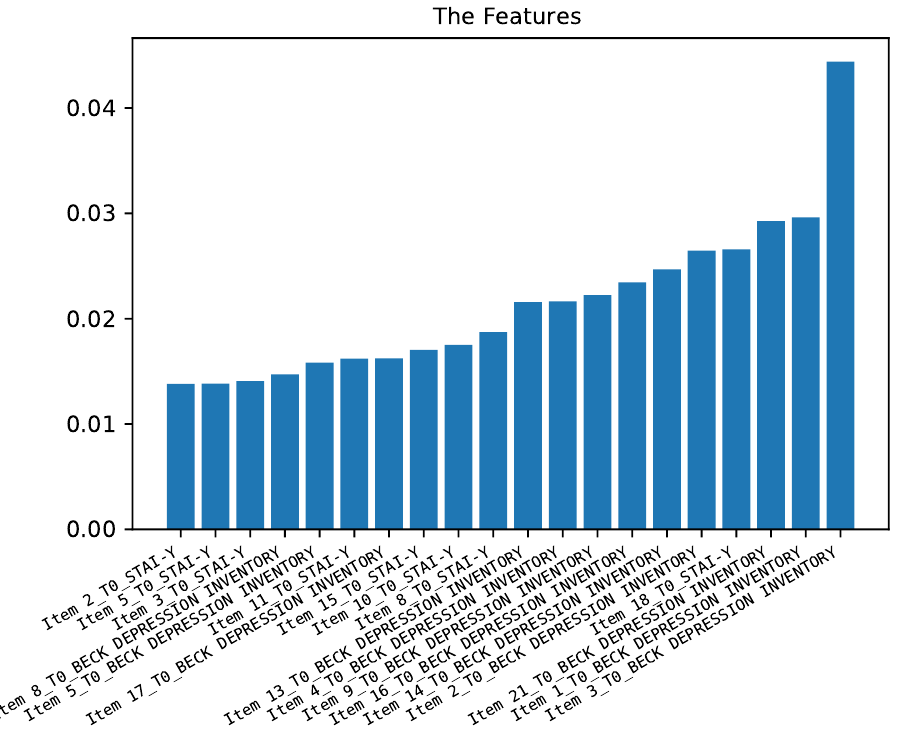
Figure 3. Importance of the different features for predicting depression symptoms.